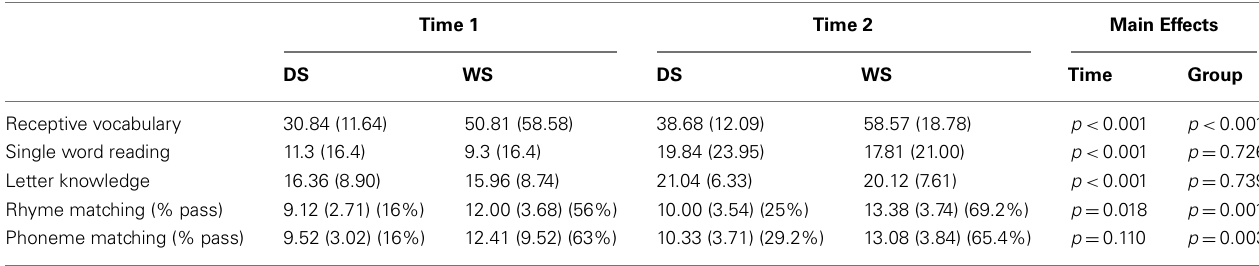
Table 5 | Longitudinal